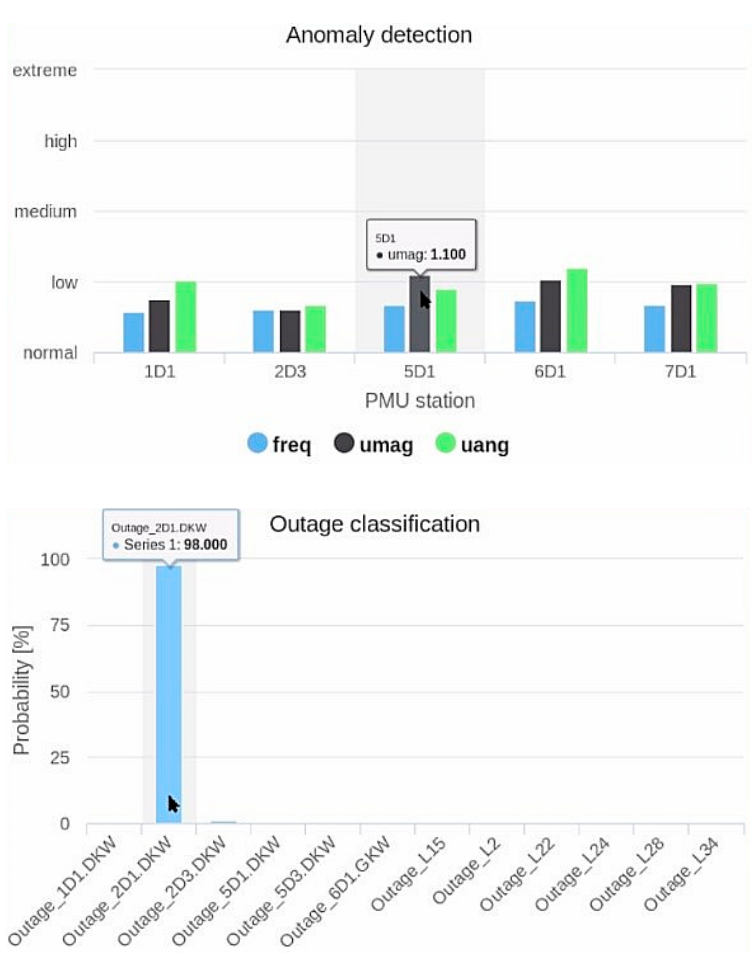
Figure 24. Exemplary online visualization charts for anomaly detection ( top ) and disturbance classification ( bottom ) of synchrophasor based applications.